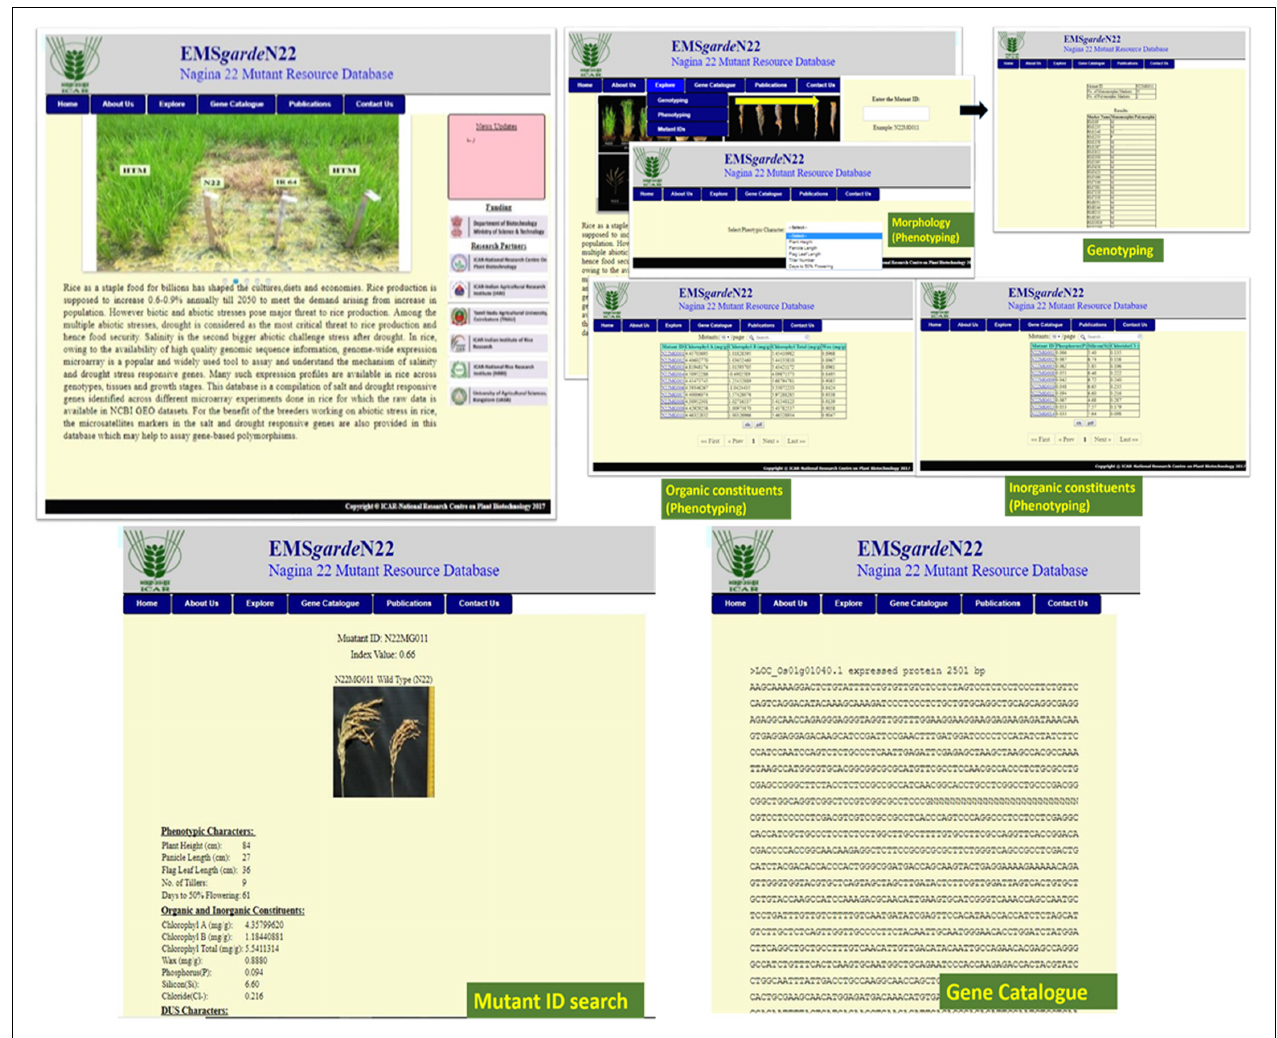
FIGURE 8 | Snapshot of the mutant garden database indicating the available search